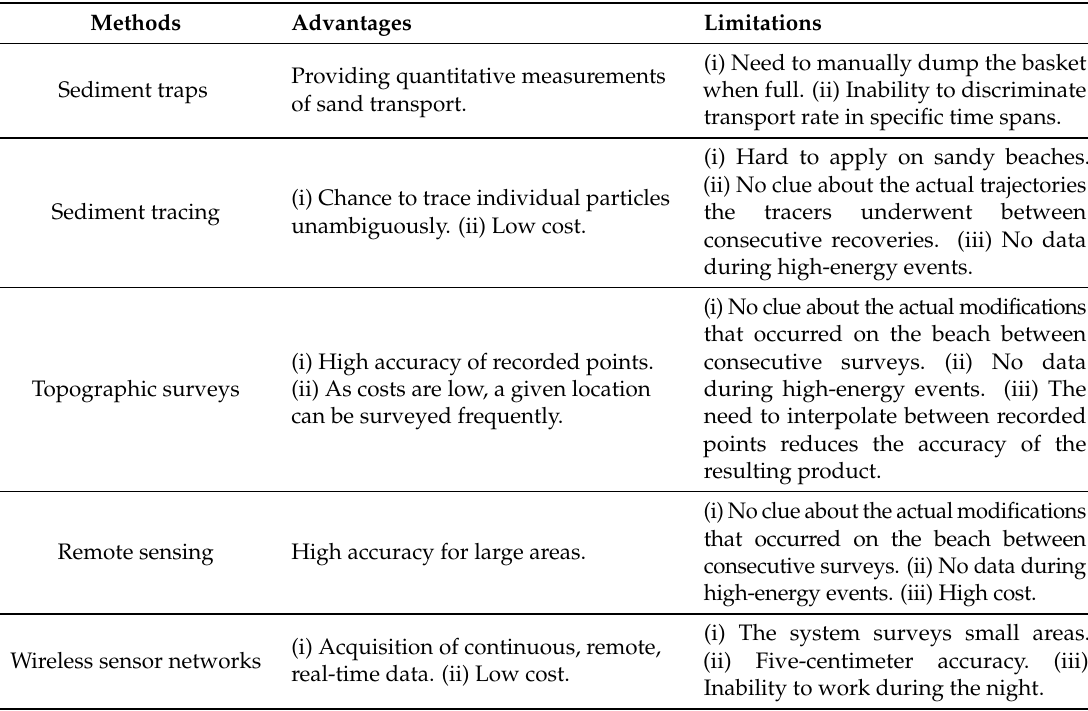
Table 1. Advantages and limitations of state of the art methods to measure sediment